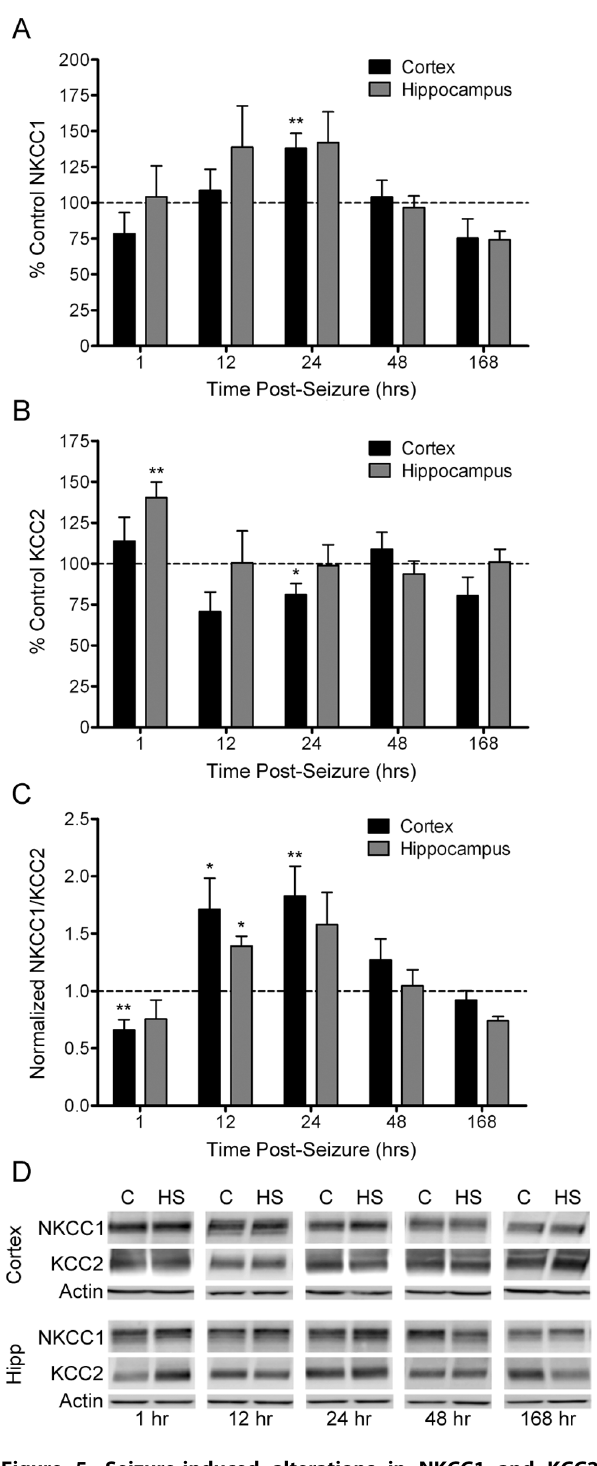
Figure 5. Seizure-induced alterations in NKCC1 and KCC2 protein levels. Using Western Blot, NKCC1 and KCC2 protein levels were assessed in cortical and hippocampal tissue obtained from P10 rats at 1, 12, 24, 48, and 168 hr after hypoxia-induced seizures (HS), and compared to age-matched littermate controls. Optical densities for NKCC1 and KCC2 were normalized to actin, averaged for each time point, and then the average expression in hypoxic animals was normalized to that in control animals. NKCC1 (A) and KCC2 (B) expression was plotted as a percent of control (dotted line). NKCC1 increased transiently at 24 hr post-HS (n=8, 138 6 10.5% control,